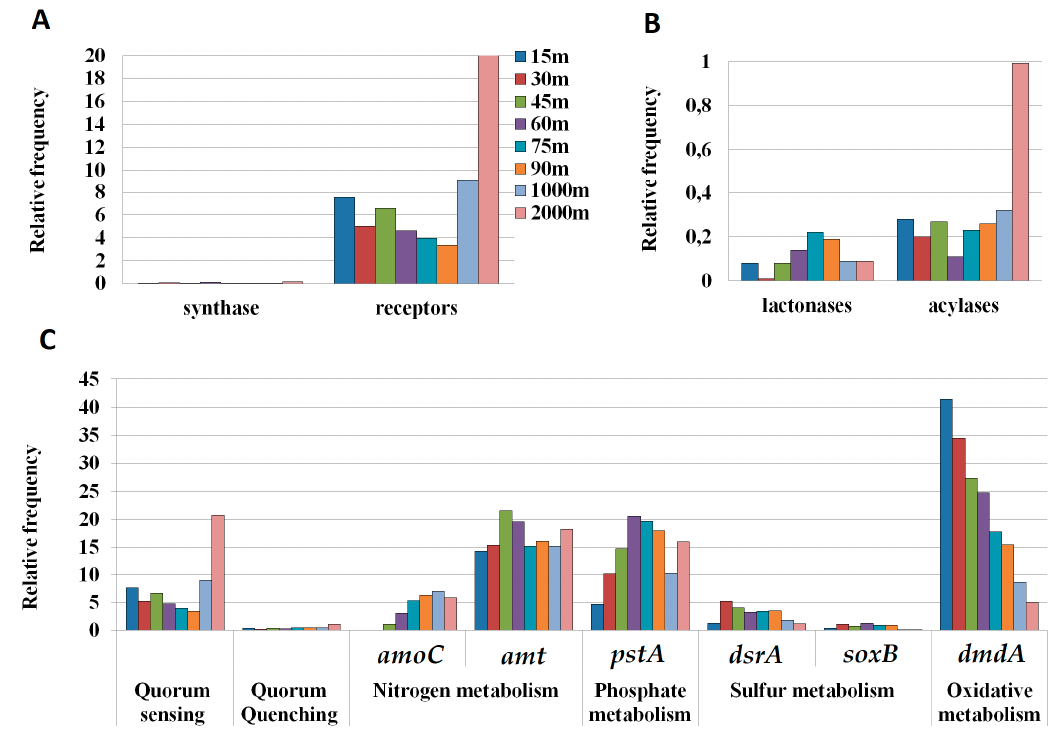
Figure 4. ( A ) Relative frequencies of AHL synthases and AHL receptors; ( B ) relative frequencies of QQ genes including lactonases and acylases; ( C ) relative frequencies of AHL ‐ based QS and QQ sequences in comparison to other genes involved in nitrogen ( amoC , amt ), phosphate ( pstA ), and sulfur ( dsrA , soxB ) acquisition, as well as in oxidative metabolism ( dmdA ). The data was normalized in function of the abundance of the recA and radA housekeeping